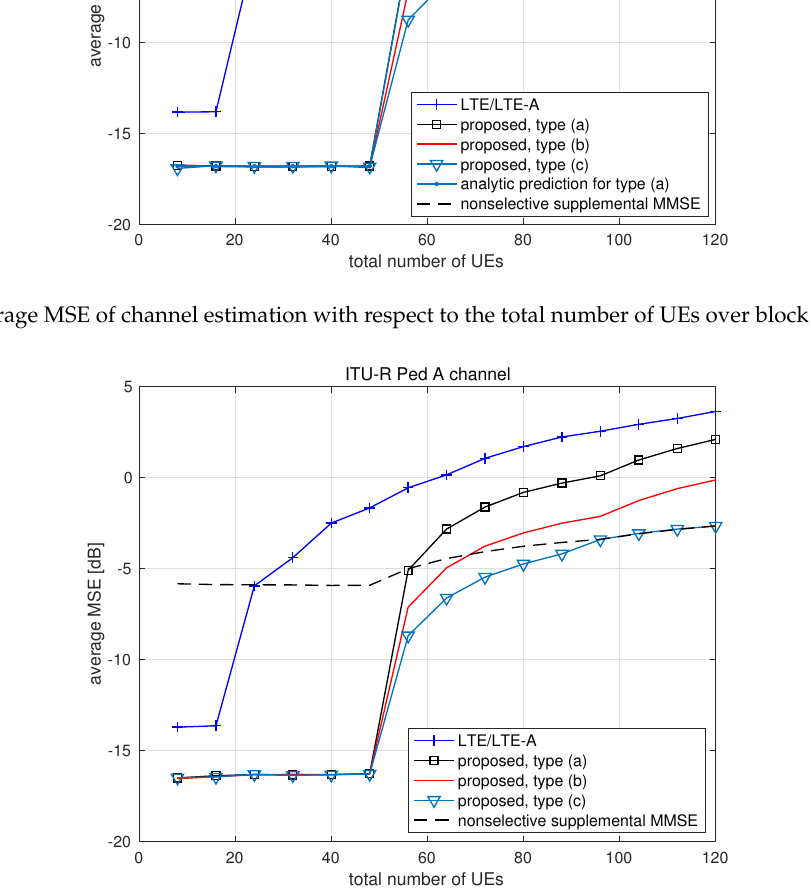
Figure 4. Average MSE of channel estimation with respect to the total number of UEs over ITU-R Ped A